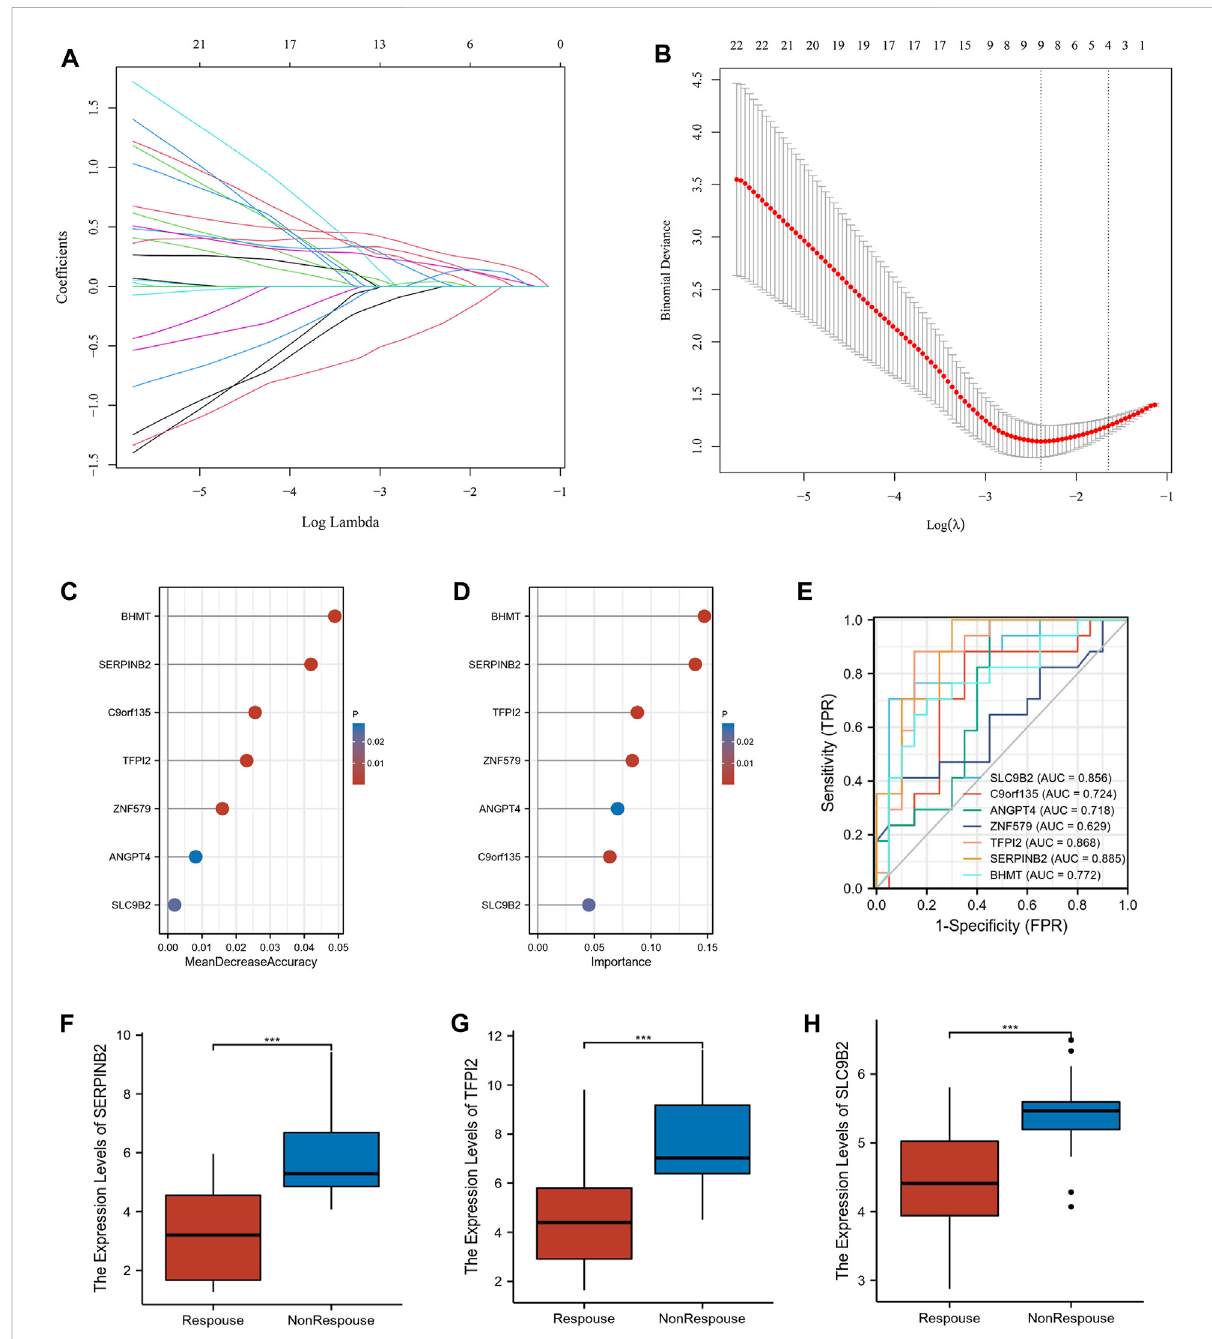
Screeningthepotentialbiomarkers. (A) LASSOcoef fi cientpro fi lesoftheintersectedgenes. (B) Selectionoftheoptimaltuningparameter( λ ). (C) Lollipop chartofbiomarkersselectedbyRF. (D) Lollipop chartofbiomarkersselectedbySVM-RFE. (E) Receiveroperatingcharacteristic(ROC) ofthe selected biomarkers (F – H) The expression levels of SERPINB2, TFPI2, and SLC9B2 in response and nonresponse groups in GSE16879, respectively. (*** p <